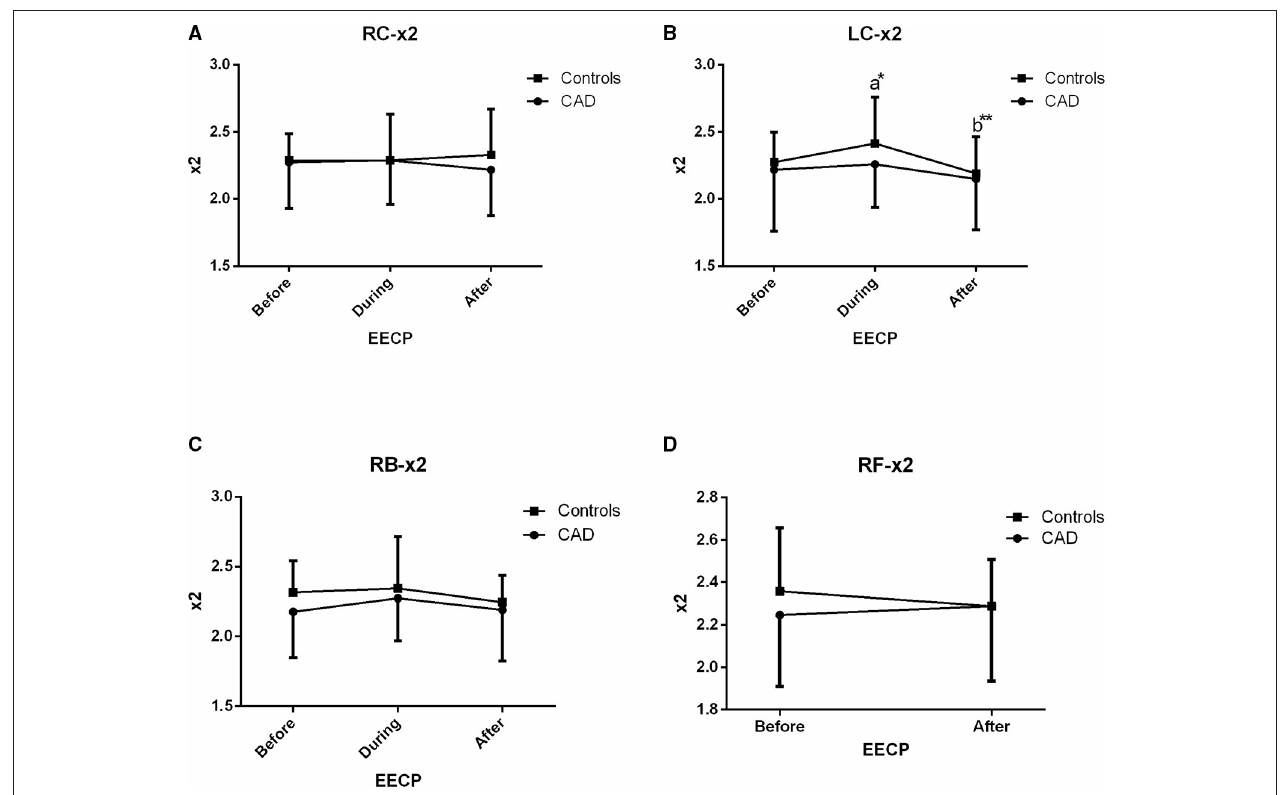
FIGURE 6 | Effect of EECP on the second frequency (x2) of RC and LC artery (A,B) , RB artery (C) , and RB artery (D) in patients with CAD and controls before, during and after 45min EECP. a indicates significant differences in measurements obtained during EECP vs. pre-EECP and b indicates differences between post-EECP vs. during-EECP. “*” and “**” denote values of p < 0.5 and < 0.01,